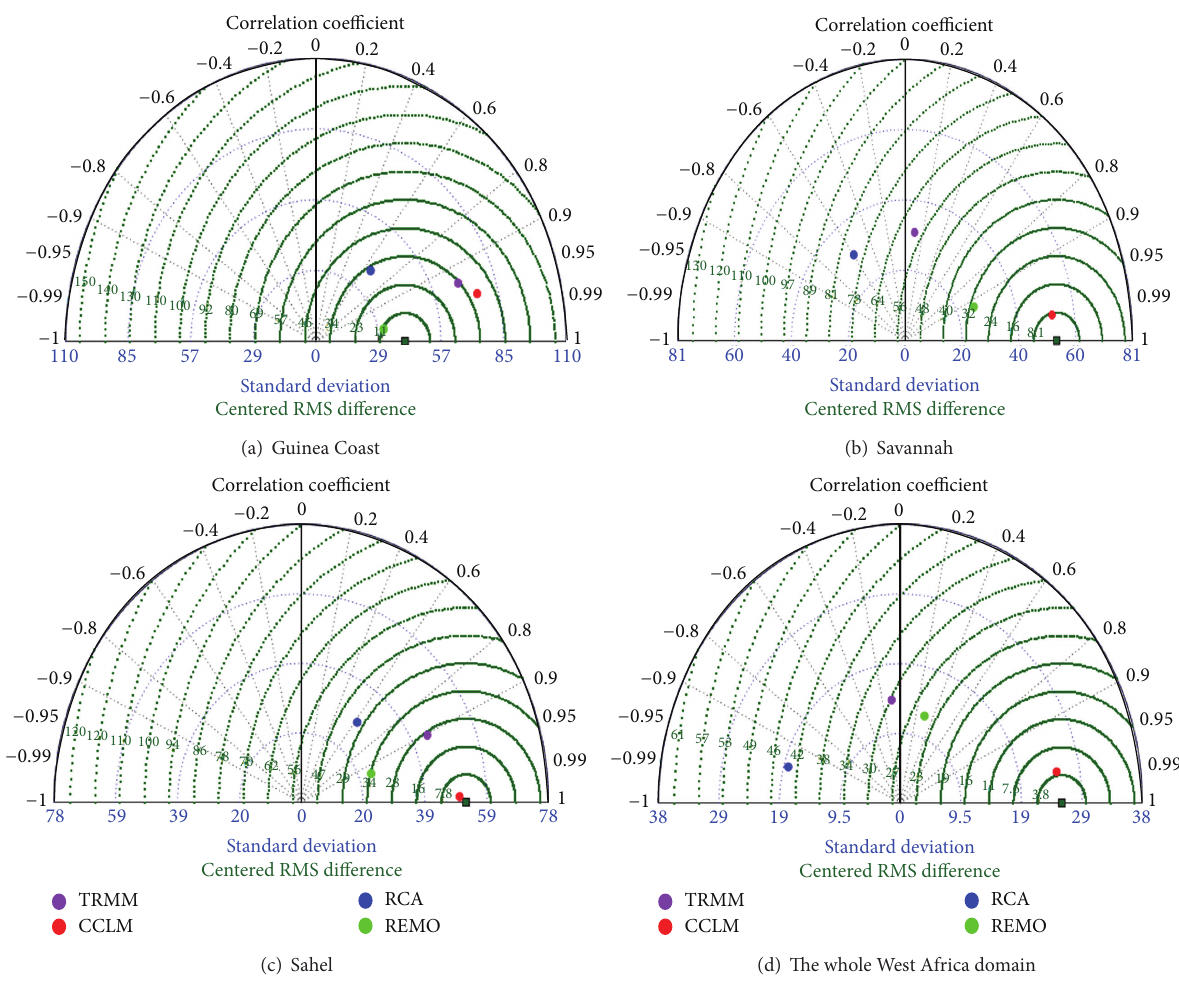
Figure 10: Taylors diagram per subregion for (a) Guinea Coast, (b) Savannah, (c) Sahel, and (d) the whole West Africa domain during JJAS for the period of